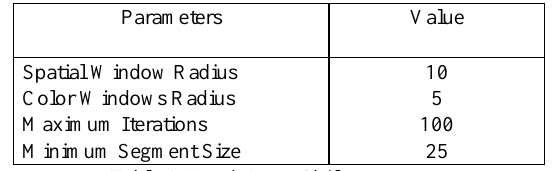
Figure 1. Lake Constance (Google maps) The properties of SENTINEL-1A SAR and SENTINEL-2A data are given in Table 1 and Table 2 respectively.